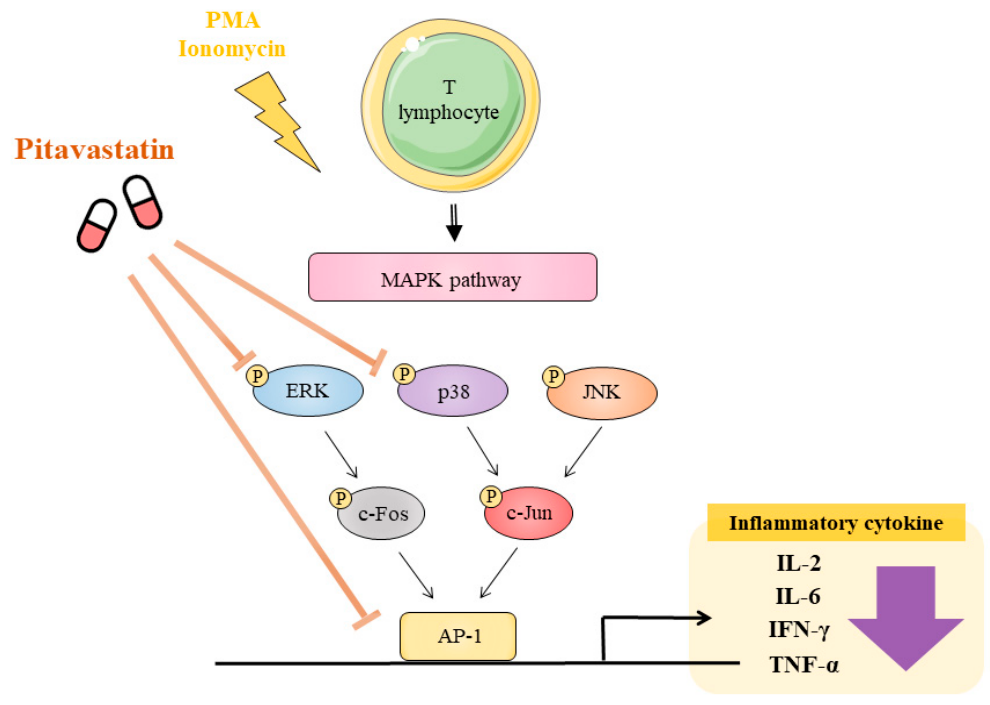
Figure 5. Schematic diagram of the anti-inflammation effects of pitavastatin in human primary T cells. Pitavastatin suppressed proinflammatory cytokine secretion through the inhibition of ERK/p38 MAPK pathways in PMA+ionomycin-activated human T cells and the reduction of transcriptional activity of AP-1 in PMA+ionomycin-activated 293T cells.